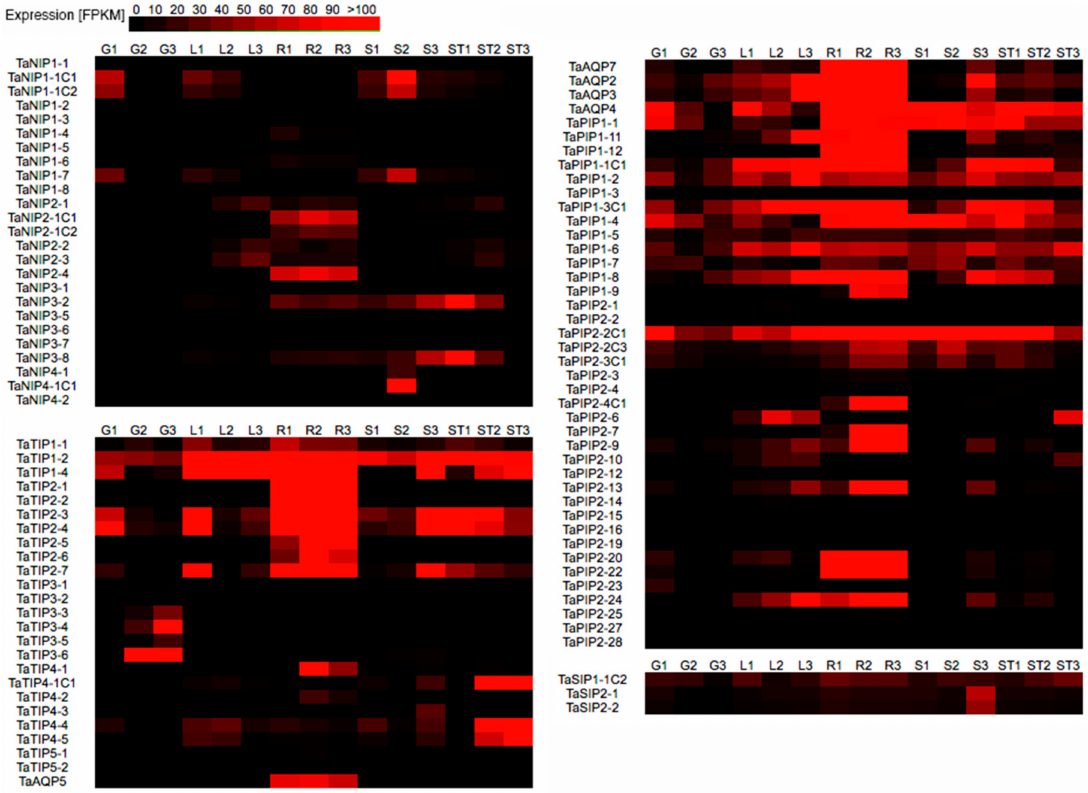
Figure 5. Analysis of AQP expression in different organs and developmental stages of wheat. Each heatmap corresponds to a subfamily of AQP. The intensity of the red color indicates the level of up-regulation of the gene in FPKM values. Development stages are